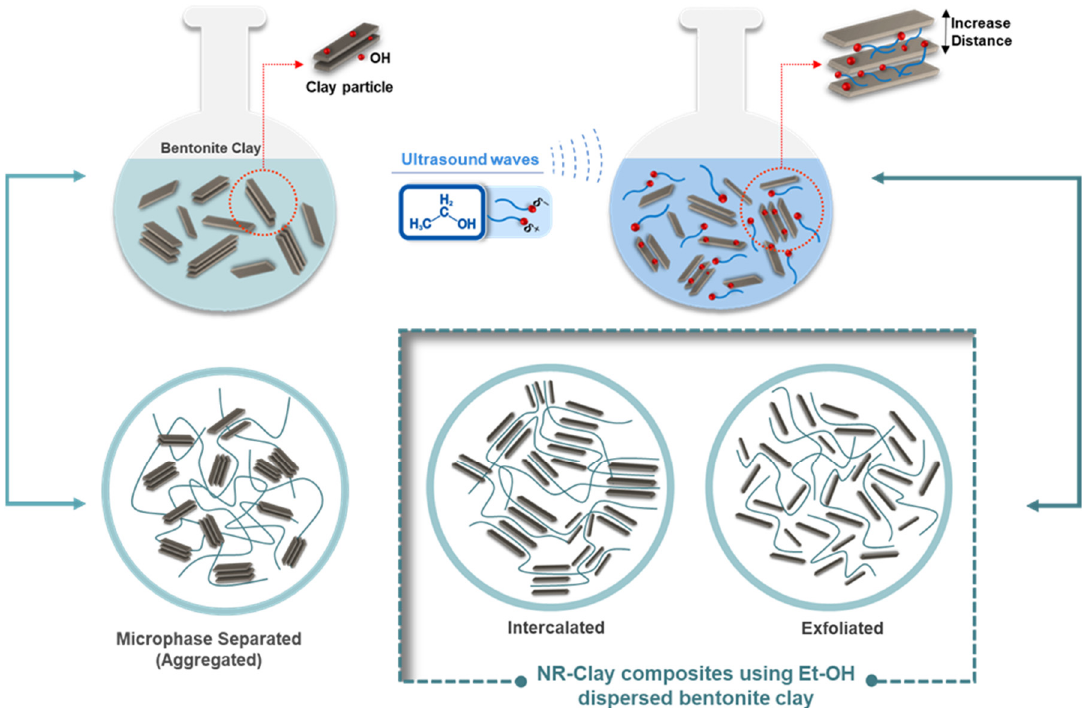
Figure 7. The proposed model and interaction between NR and bentonite clay in NR/Clay compo- sites.